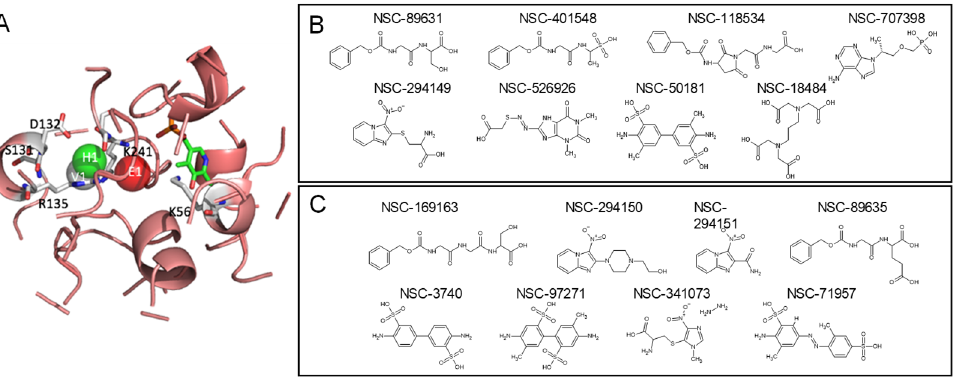
Figure 4. ( A ) The site moiety map of the holo form of SRR, which keeps the PLP as a cofactor ligand. ( B ) Potential modulators with PLP as a cofactor ligand. ( C ) Derivatives of potential modulators.